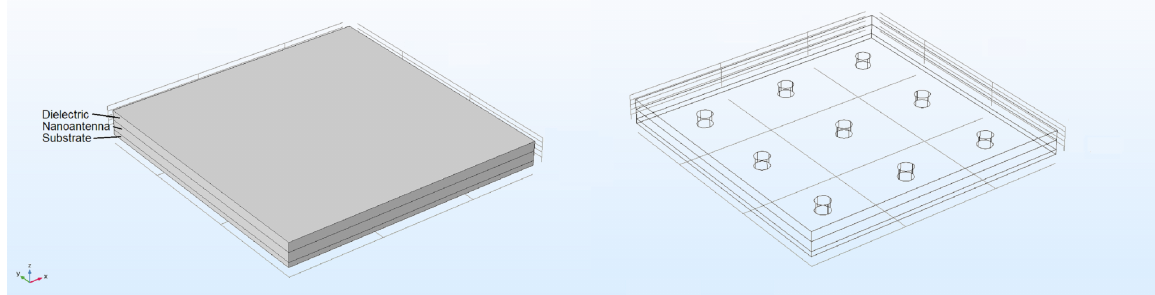
Figure 1. Topology of the simulated